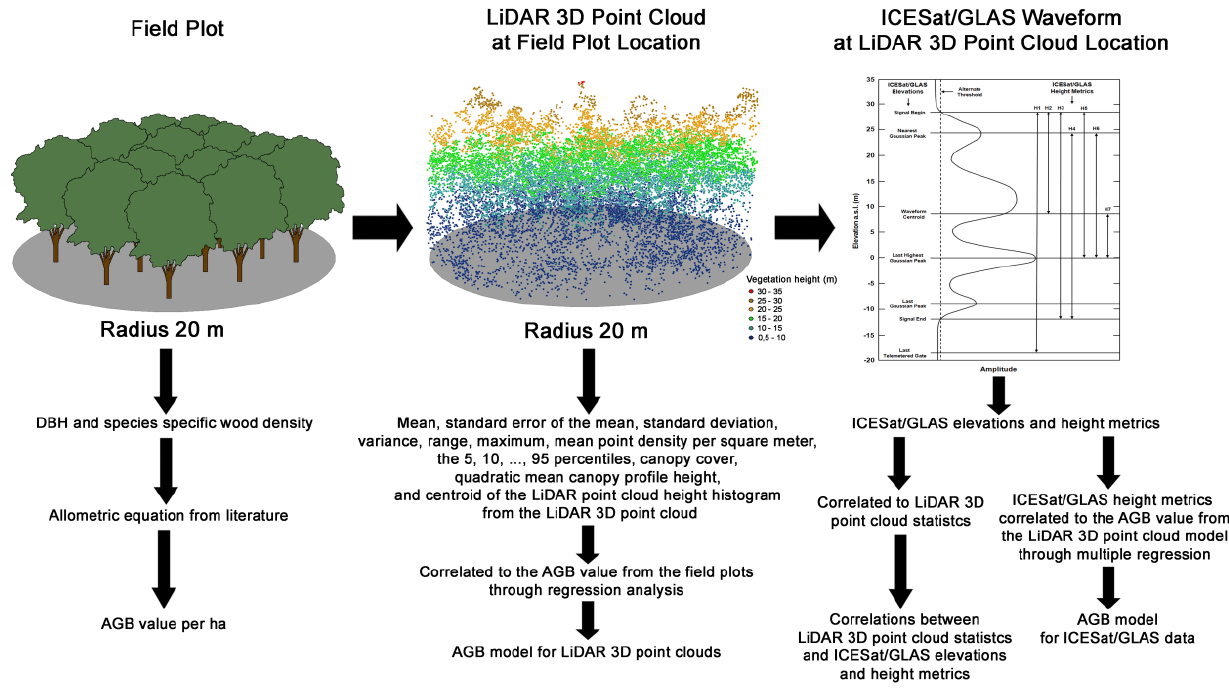
Figure 4. Overview of the methodology to derive Above Ground Biomass (AGB) values from the field plots (left), the development of AGB models by correlating AGB from the field to airborne LiDAR 3D point clouds statistics (middle), and the correlation of ICESat/GLAS elevations and height metrics to LiDAR 3D point cloud statistics and the development of a AGB model by correlating AGB results from the airborne LiDAR AGB model to ICESat/GLAS height metrics